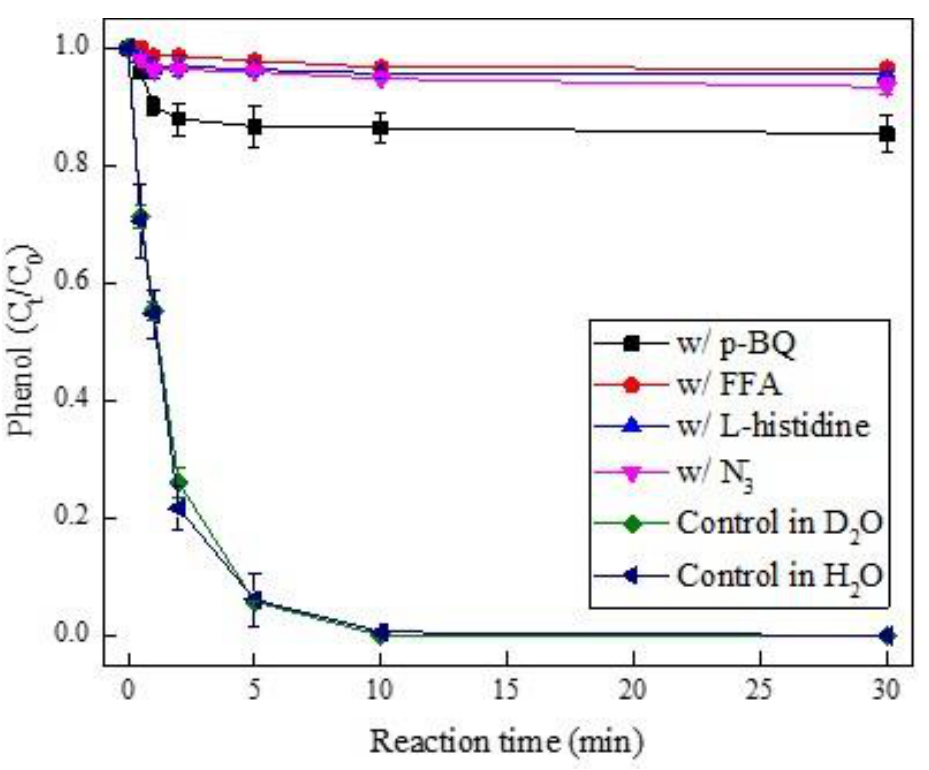
Figure 3. The effect of 1 O 2 scavengers and D 2 O solution on phenol degradation in the Pd(II)/PMS system. Condition: [phenol] = 50 µ M, [PMS] = 0.25 mM, [Pd(II)] = 25 µ M, [FFA] = [L-histidine] = [N 3 − ] = 200 mM, [p-BQ] = 100 mM, pH i =